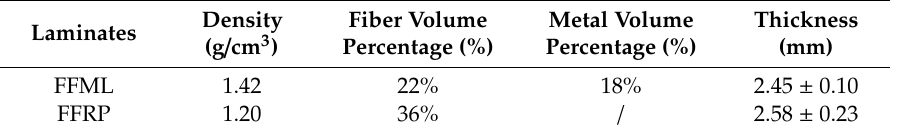
Table 2. The parameters of flax fiber–metal laminates (FFMLs) and flax fiber-reinforced plastic (FFRP)